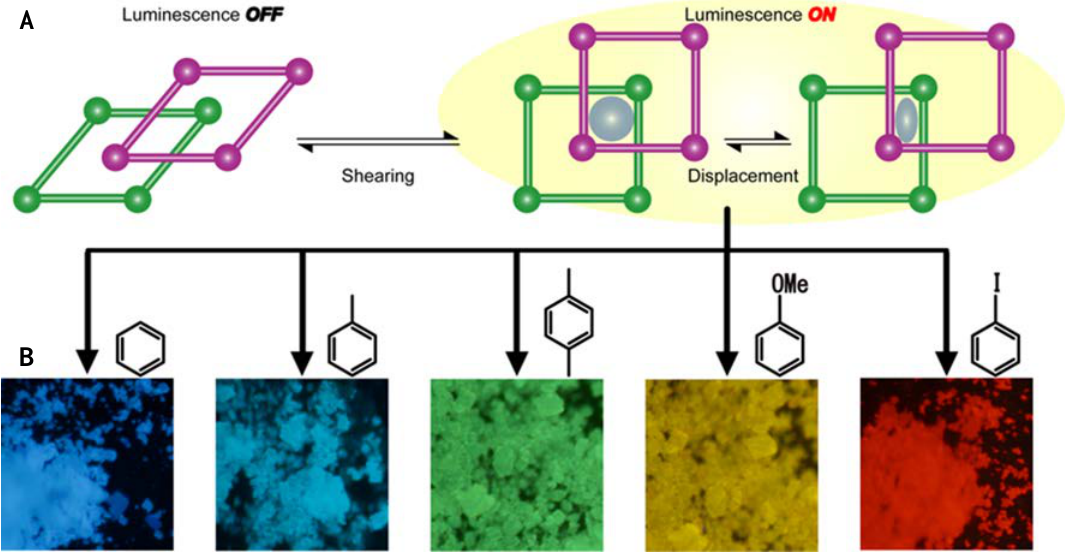
Figure 2. (A ) Structural dynamics of the MOF on the accommodation of different guest molecules. ( B ) fluorescence image of [Zn 2 (bdc) 2 (dpNDI)] n powder with different VOC (Volatile Organic Compounds)molecules occluded in the pore: benzene, toluene, p -xylene, anisole and iodobenzene.